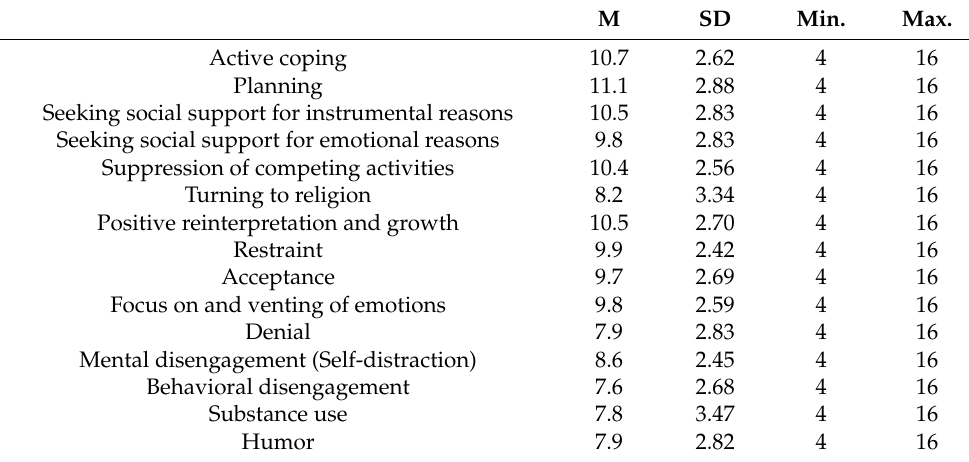
Table 2. Descriptive statistics for strategies of coping with stress ( N =